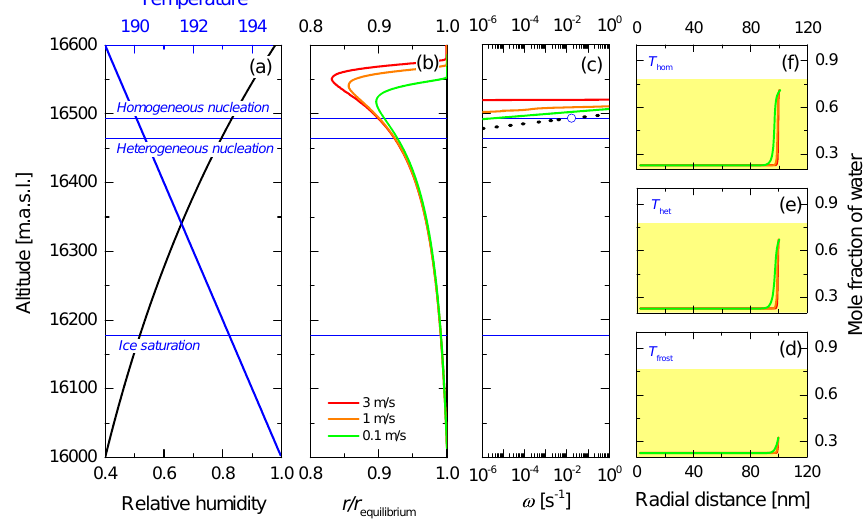
Figure 5. Same as Fig. 4 but for organic aerosol particles experiencing adiabatic updrafts under conditions typical of the very high upper troposphere in the tropics, starting at 40% RH and 195K with linear updraft velocities of 0.1, 1 and 3ms − 1 . In (c) the homogeneous freezing temperatures are lowered by 0.10K for 0.1ms − 1 updraft velocity and 0.28K for 3 ms − 1 updraft